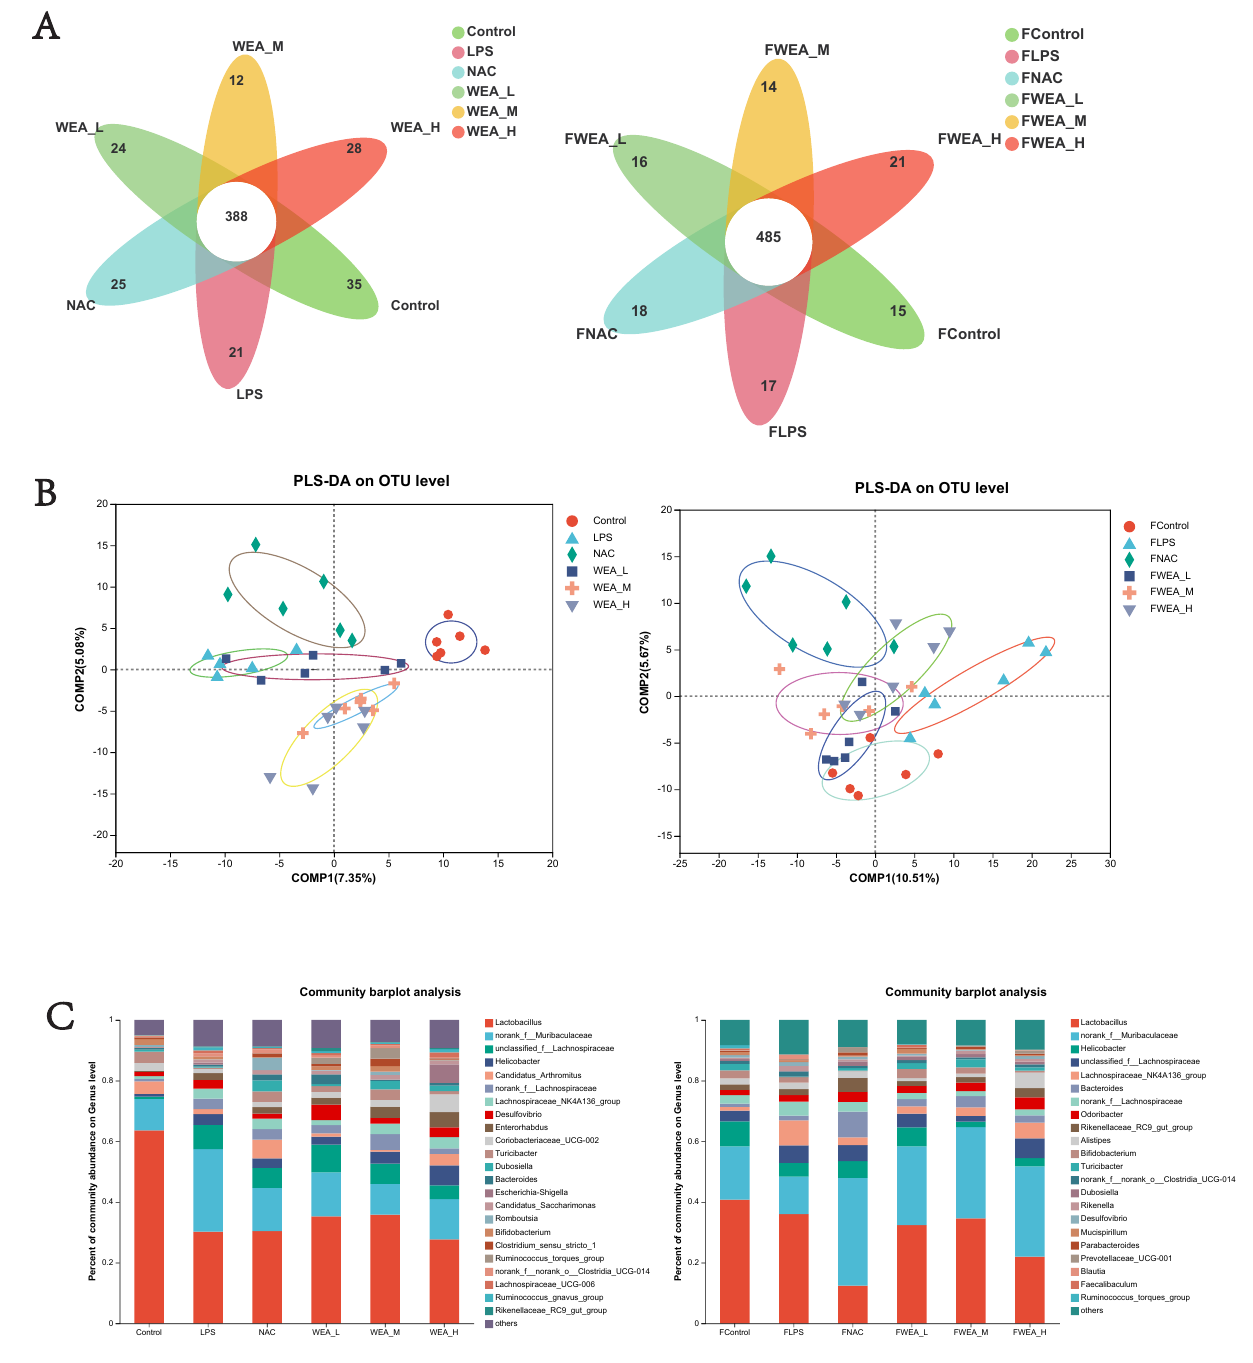
Figure 8. Composition of the gut microbiota. ( A ) Venn diagrams, ( B ) PLS-DA score plots, and ( C ) bacterial taxonomic compositions at the levels of genus in the intestinal digesta and the